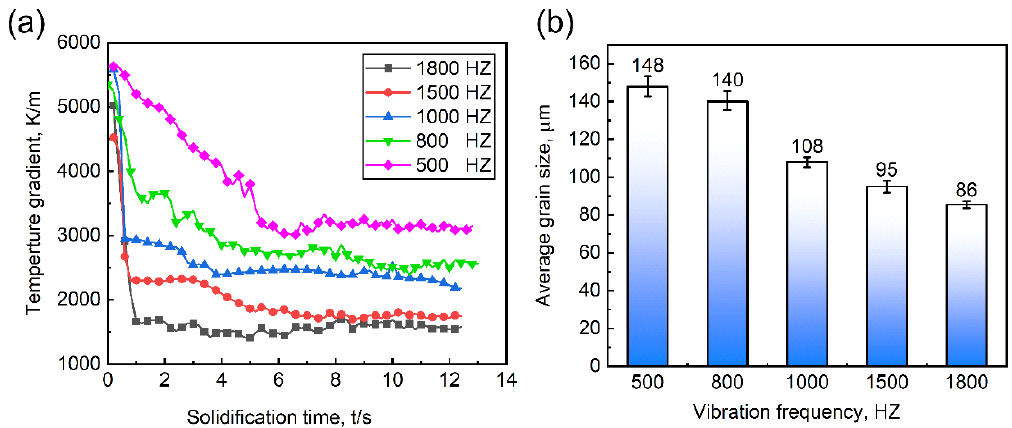
Figure 11. Quantitative analysis of temperature field distribution characteristics and grain size information. ( a ) Temperature gradient distribution between A and B positions under different vibration frequencies. ( b )The average grain size under different vibration frequencies.